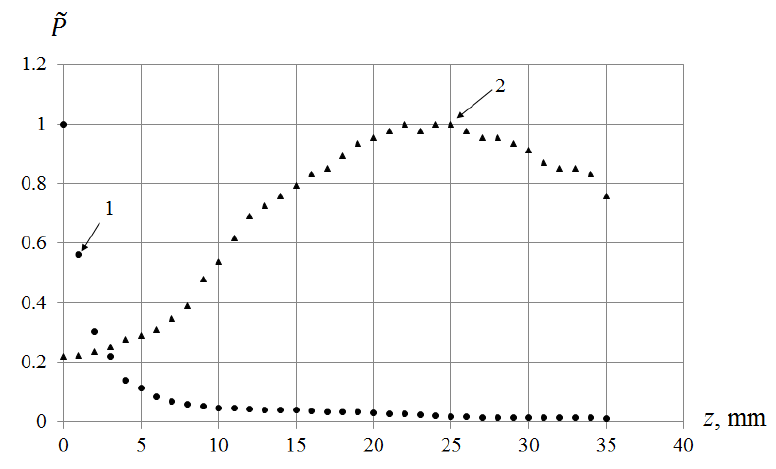
Fig. 3. The dependence of the normalized power flux density on the longitudinal coordinate z